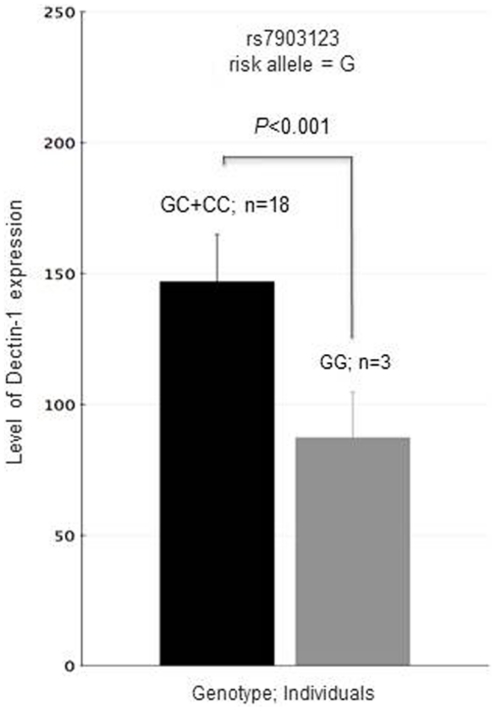
Correlation between Dectin-1rs7903123 genotype and expression of Dectin-1 as measured by quantitative PCR in total RNA from healthy donors (n = 21).Dectin-1 mRNA levels were normalized for GAPDH mRNA levels. FirstChoice®Human Brain Reference RNA was used as Calibrator (Ambion; Catalog number AM6050).